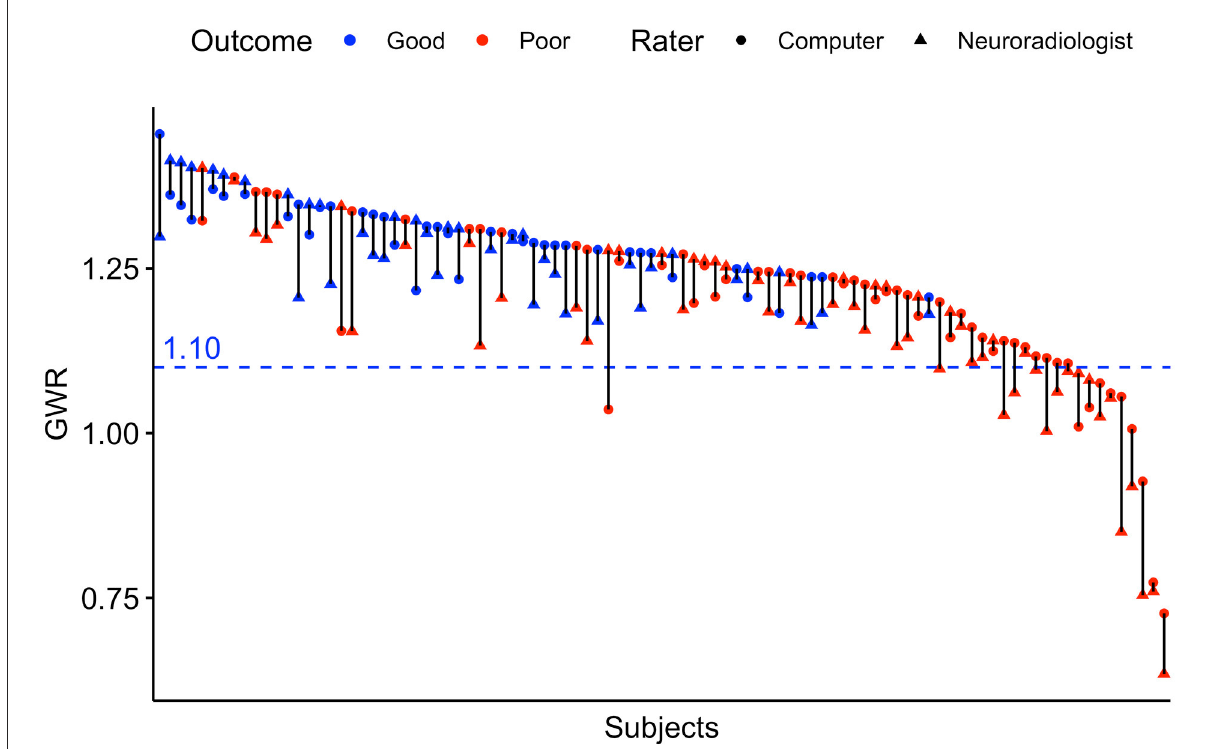
FIGURE4 Pairwise GWR values for n = 95 patients rated by computer and neuroradiologist. Blue pairs representing patients with good outcome (CPC 1–3), red pairs poor outcome (CPC 4–5). Triangles for manual rater (neuroradiologist), dots for computer. Blue dotted line at GWR-cutoff =